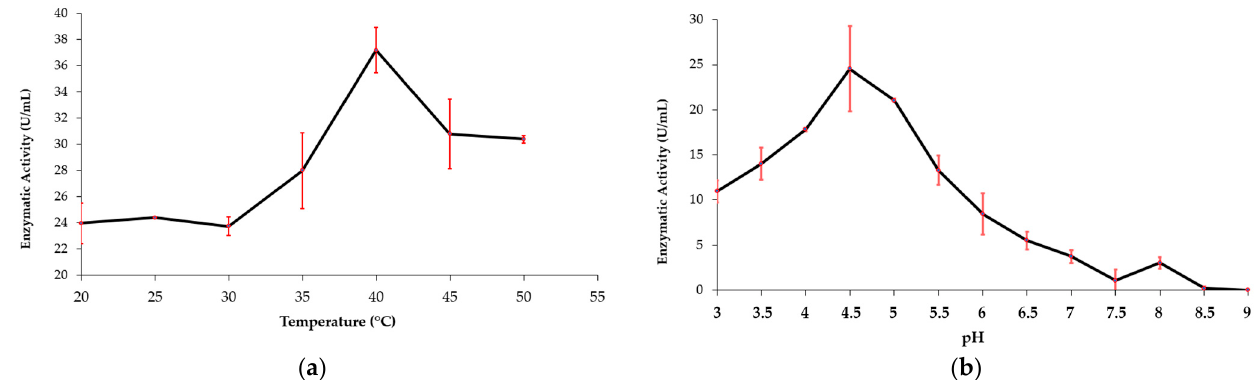
Figure 8. Effects of variation in temperature ( a ) and pH ( b ) on the activity of the MaBgl3 enzyme.